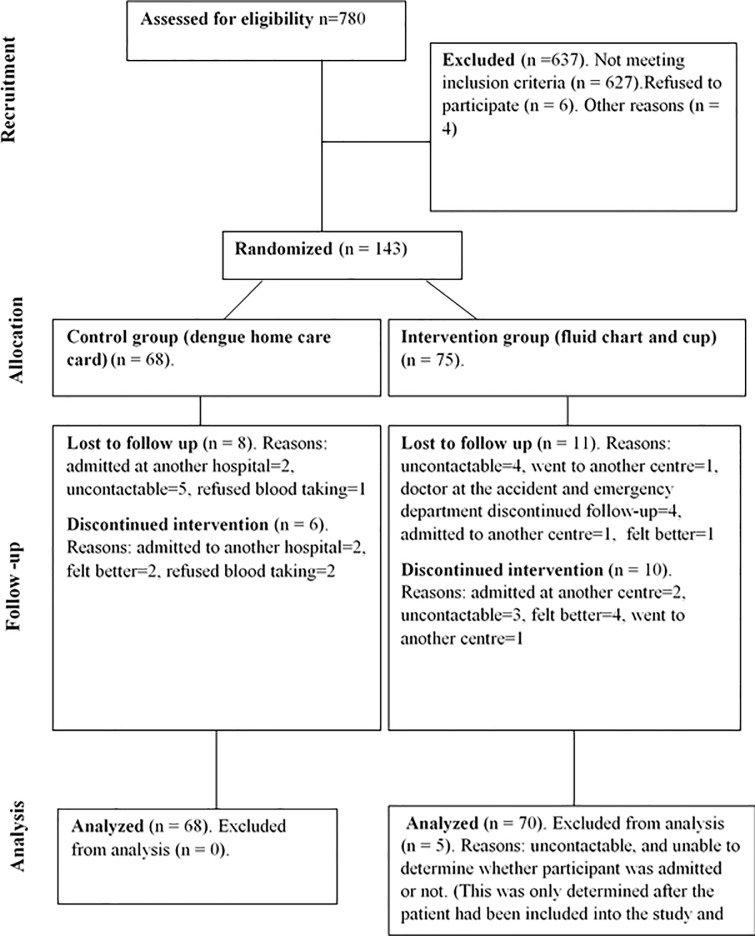
The CONSORT diagram.